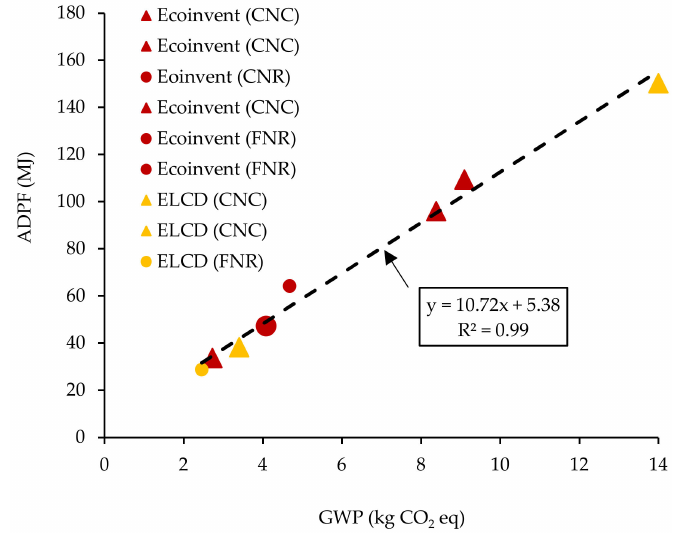
Figure 6. GWP (kg CO 2 eq) vs. ADPF (MJ) results from the generic databases, per tonne of aggregate.